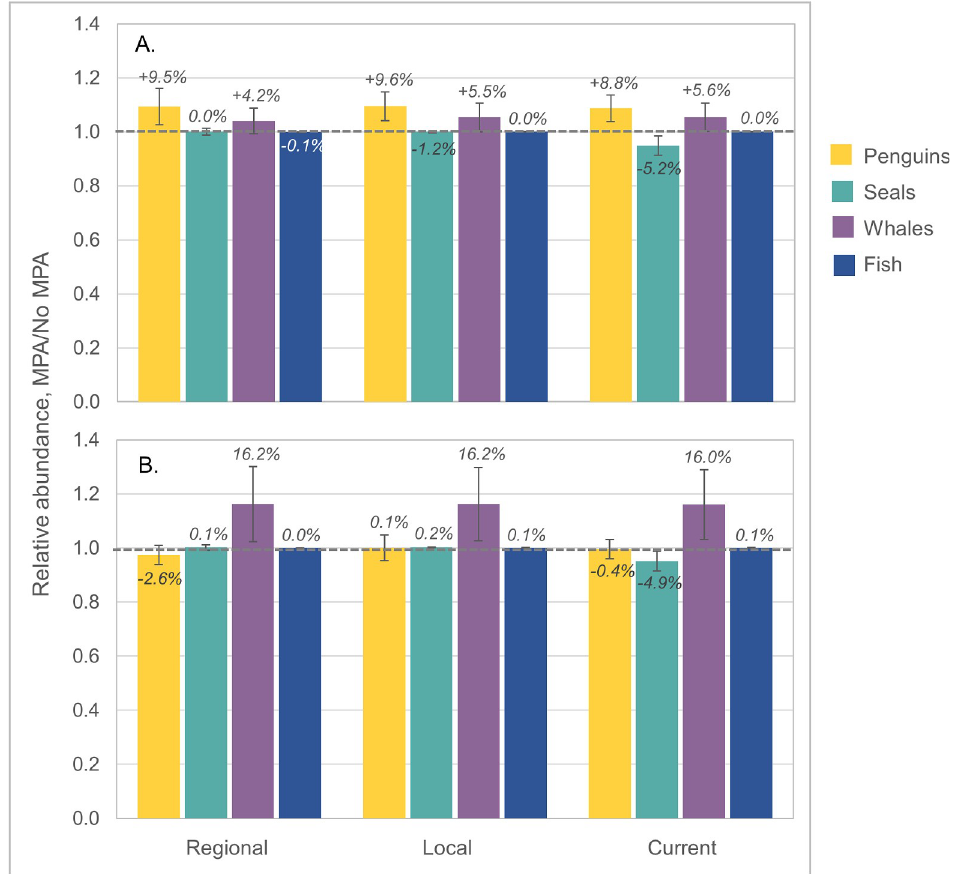
Fig 2. Relative changes, at the scale of the model arena, in overall predator abundance by species group and redistribution alternative given two MPA scenarios. Percent change in overall predator abundance by species group (penguins in yellow, seals in teal, whales in lavender, and fish in blue) during the final year of the model run for the (A) D1MPA and (B) US10 scenarios relative to the No MPA reference. The Regional redistribution alternative is the first set of bars, followed by the Local and Current alternatives. The dashed horizontal line at 1.0 indicates no change in modeled results between the MPA scenario and the No MPA reference. Bars above the line indicate increased abundance with the MPA, and bars below the line indicate population declines. Percent changes are labeled at the top of each bar, and error bars represent the standard deviation from the mean across all simulations in a scenario, capturing the variability across the four